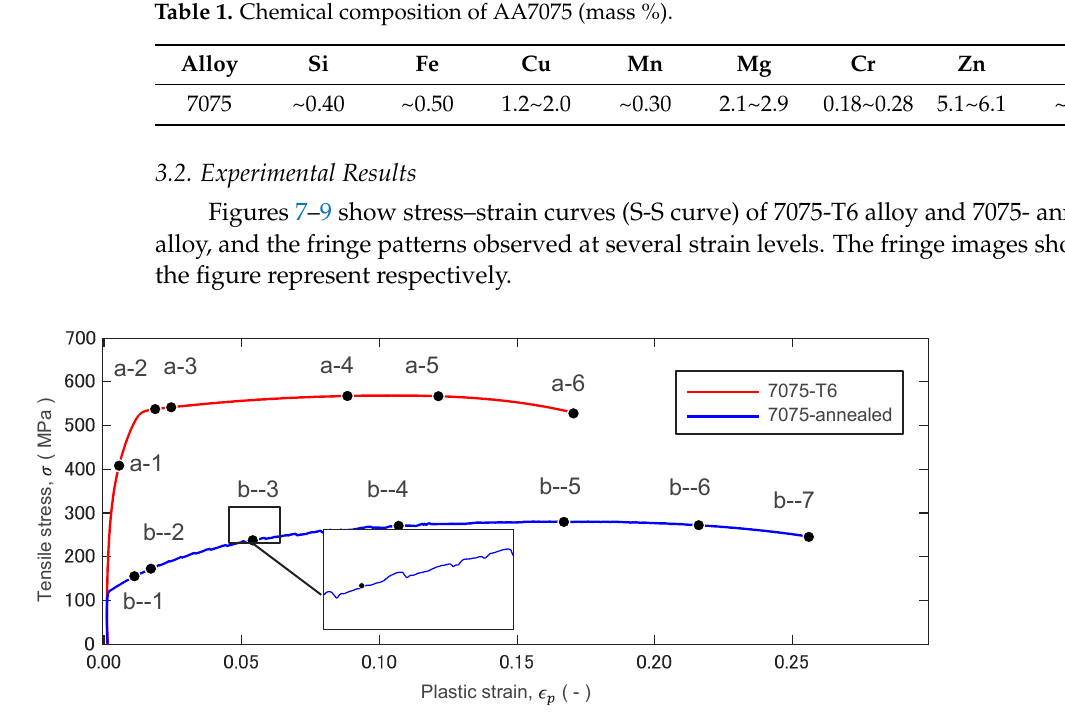
Figure 7. Stress–strain curves of 7075-T6 and 7075-annealed alloys.